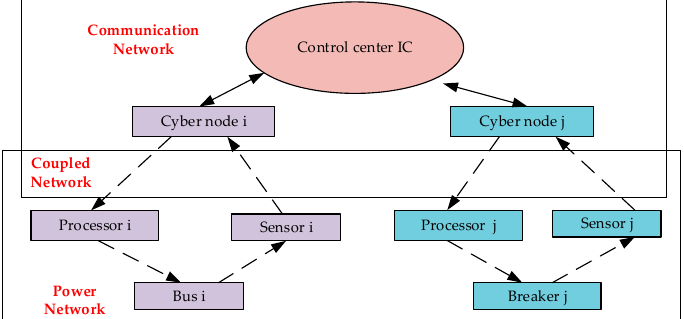
Figure 1. Architecture of cyber–physical interdependent network.